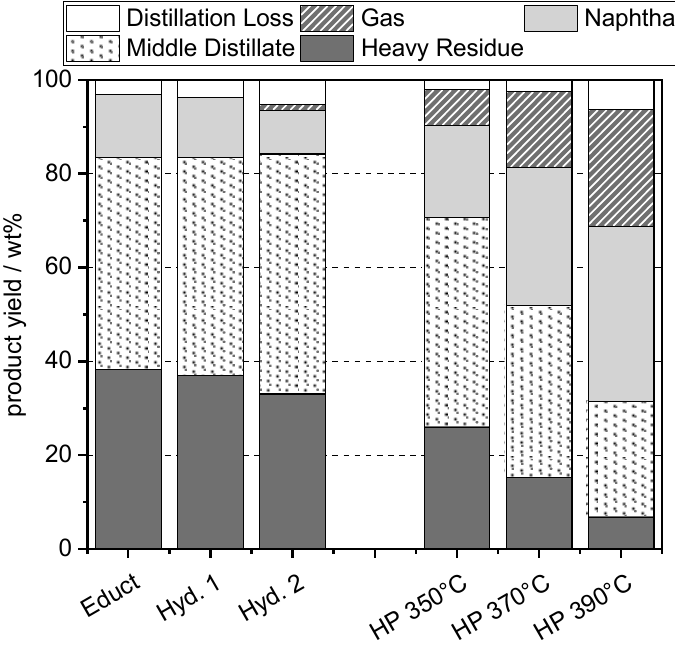
Figure 6. Product yield of pyrolysis wax hydroprocessing as listed in Table 2. The yield composition of the pyrolysis wax hydroprocessing was compared to the those of the FT wax at identical process parameters. The results are depicted in Figure 7. While the trends of increasing naphtha and gas yields while simultaneously decreasing the amount of middle distillate and heavy residue stay identical, the overall composition is different. The pyrolysis samples show constantly higher amounts of fuel fractions than those of their FT counterparts. The produced gas phase for PW is also increasing significantly faster with temperature. These effects can be attributed to the higher amount of short chain molecules formed in the pyrolysis process. Interestingly, the amount of liquid product lost into the gas phase is rather similar for lower reaction temperatures, despite the shorter chains in the PW samples. This indicates a higher cracking preference of long chains as compared with shorter chain molecules, which are only removed, once the temperature is high enough. This indicates that a removal of the naphtha phase before hydroprocessing might not significantly improve the overall liquid yield at moderate